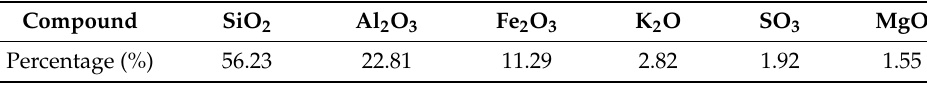
Table 2. Chemical composition of the soil